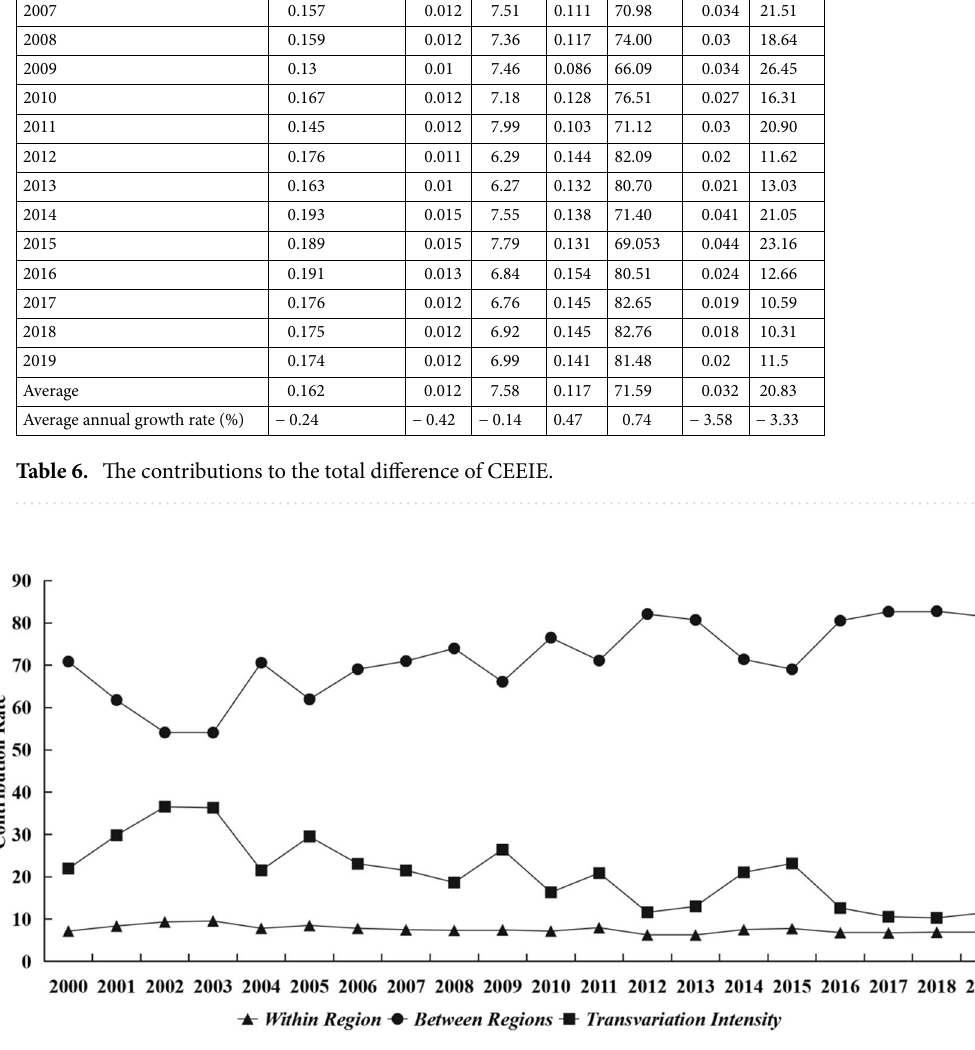
Figure 7. The trend of